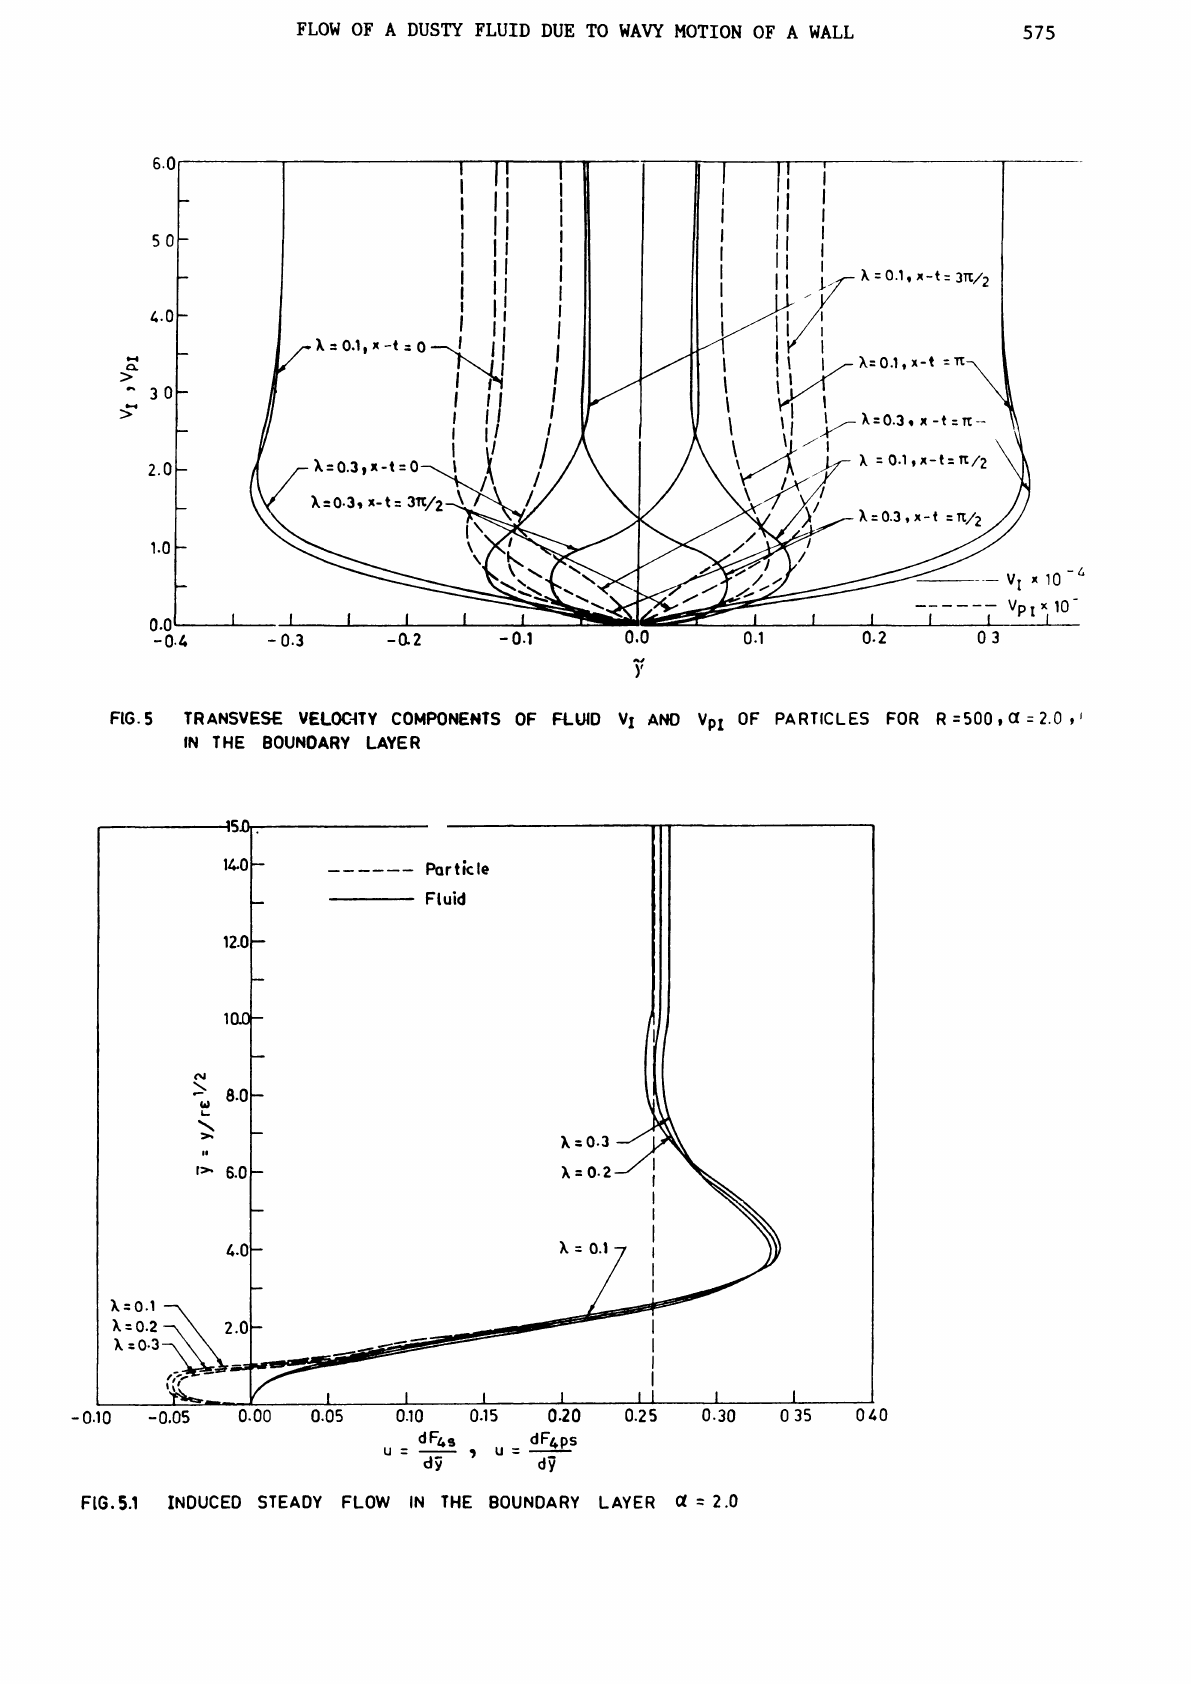
TRANSVESE VELOCITY COMPONENTS OF FLUID V AND VpI OF PARTICLES FOR R =500, cI 2.0 ,’ IN THE BOUNDARY LAYER